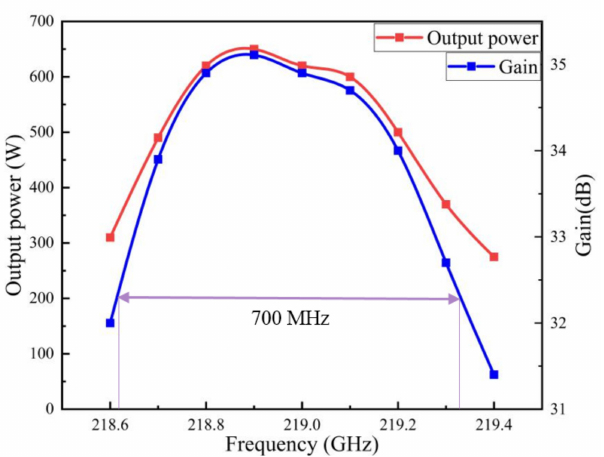
Figure 8. Output power and gain versus frequency.